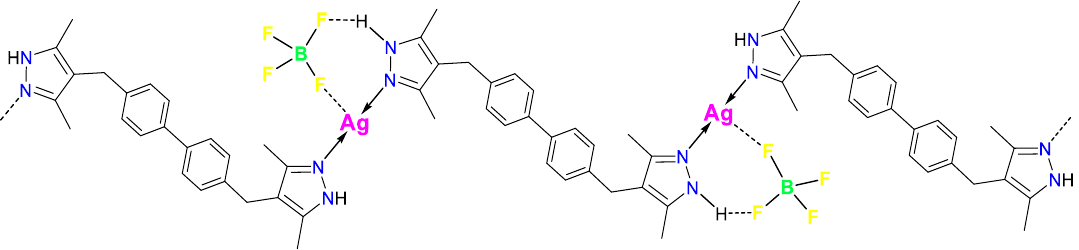
Figure 8. Proposed polymeric structure of [Ag(H 2 DMPMB)(ClO 4 )] ( 5 ), evidencing the T-shaped stereochemistry of silver(I) ions assured by the perchlorate anions and the neutral ligands Figure 7. Proposed polymeric structure of [Ag(H 2 DMPMB)(BF 4 )] ( 4 ), evidencing the T-shaped Figure 7. Proposed polymeric structure of [Ag(H 2 DMPMB)(BF 4 )] ( 4 ), evidencing the T-shaped Figure 7. Proposed polymeric structure of [Ag(H 2 DMPMB)(BF 4 )] ( 4 ), evidencing the T-shaped coordinated in a bridging exo-bidentate mode. stereochemistry of silver(I) ions assured by the tetrafluoroborate anions and the neutral ligands stereochemistry of silver(I) ions assured by the tetrafluoroborate anions and the neutral ligands stereochemistry of silver(I) ions assured by the tetrafluoroborate anions and the neutral ligands coordinated in a bridging exo-bidentate mode. coordinated in a bridging exo-bidentate mode. coordinated in a bridging exo-bidentate mode.